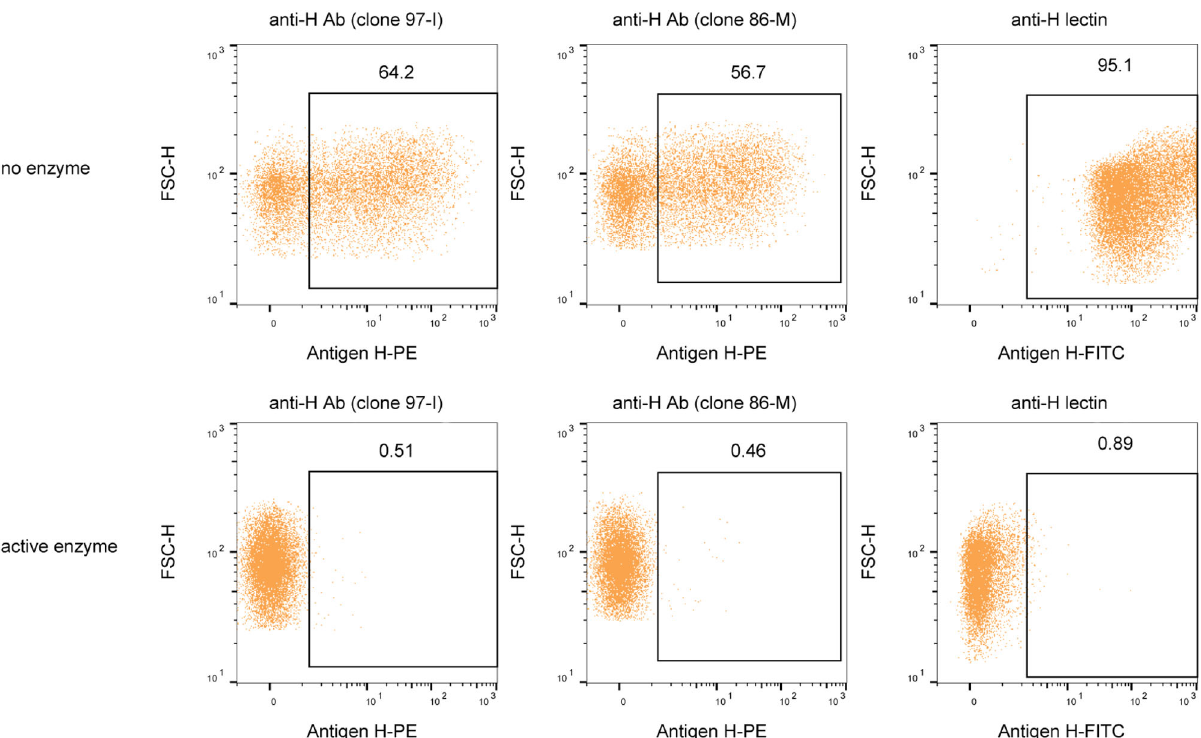
Fig. 7 | Enzymatic blood type conversion as determined by fl ow cytometry. Different labeling strategies for the analysis of antigen H expression in RBCs. Dot plot graphs showing the frequency of antigen H+RBCs from an O blood group sample donor non-incubated and incubated with the active FucOB (5 µ gmL − 1 fi nal